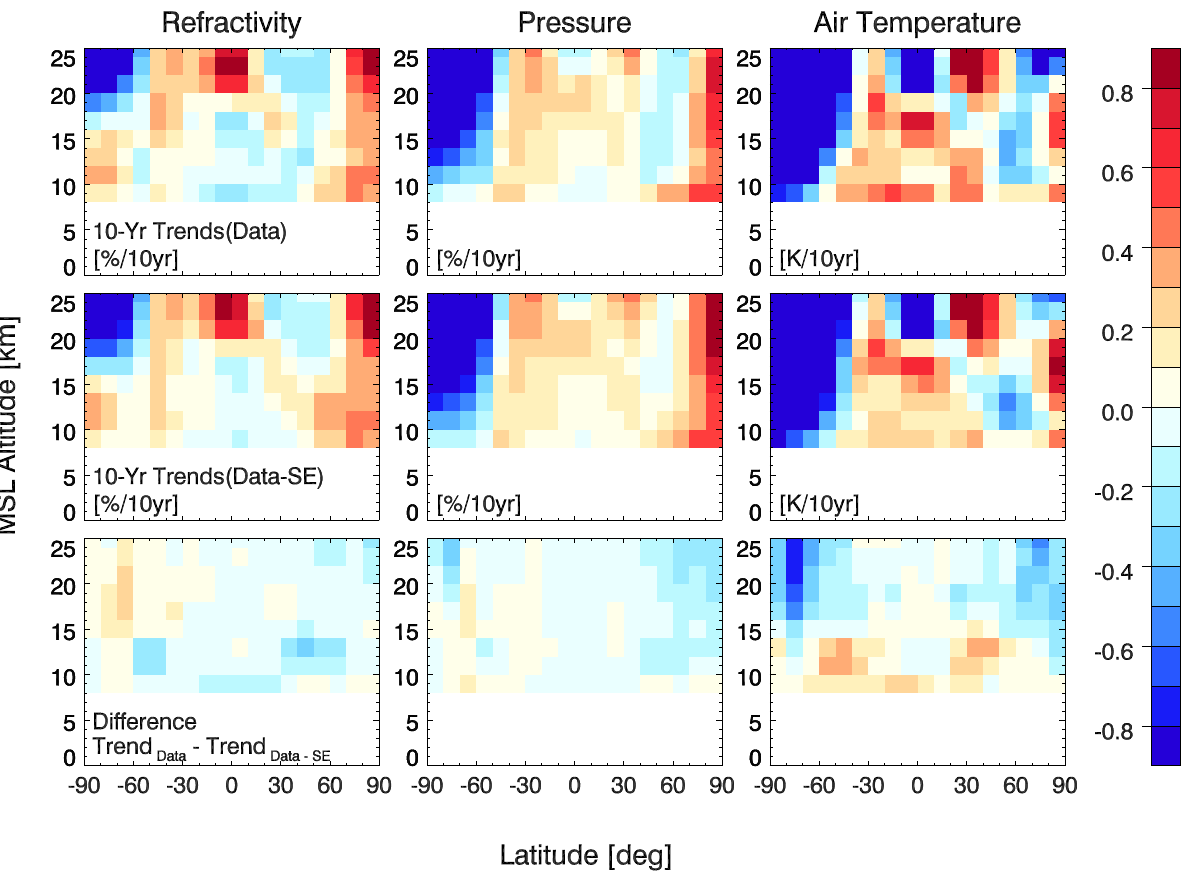
Fig. 1. RO multi-satellite (CHAMP, Formosat-3/COSMIC satellites 1–6, GRACE-A) trend patterns for relative refractivity (left), relative pressure (middle), and temperature (right). Depicted are in the top row 10-year trends based on the period September 2001 to July 2010 (Wegener Center OPSv5.4 data; Steiner et al., 2009; Pirscher, 2010). The trends originate from time-series of monthly mean RO anomalies (from each month the mean of all respective months was subtracted). Middle row shows same format as top, but based on anomalies from which the sampling error was removed before calculating the trends. Bottom row depicts the influence of removing the sampling error from data when calculating the trends (i.e. difference of top and